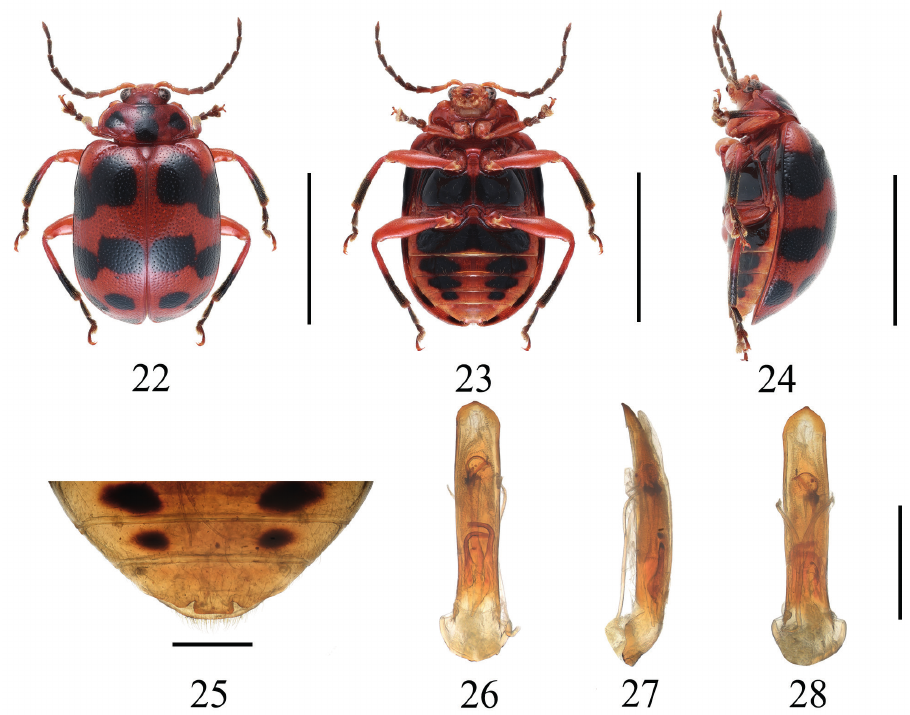
Figures 22–28. Gallerucida octodecimpunctata sp. nov. 22 dorsal view (paratype) 23 ventral view (para- type) 24 lateral view (paratype) 25 ventral view of 5 th ventrite, male (paratype) 26 aedeagus, dorsal view (holotype) 27 ditto, lateral view (holotype) 28 ditto, ventral view (holotype). Scale bars: 5 mm ( 22–24 ); 1 mm ( 25–28